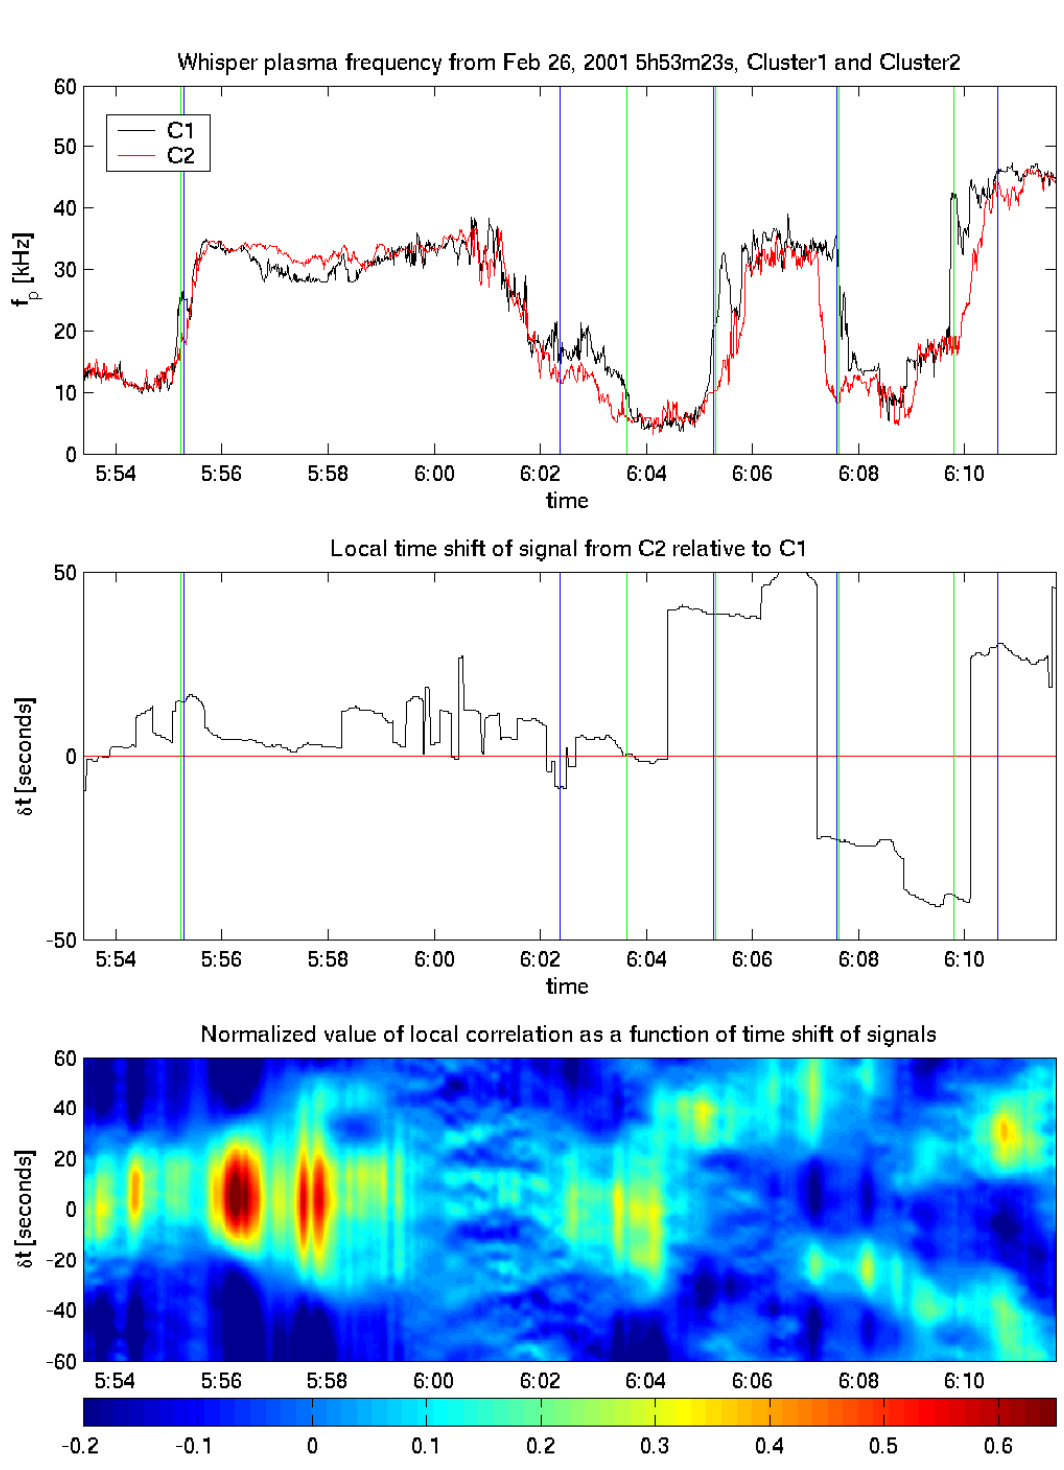
Fig. 1. Example of LWC timing, applied to the electron density measured by WHISPER during repetitive magnetopause crossings on 26 February 2001, from 5:54–6:11 UT. The upper panel shows the plasma frequency as measured by spacecraft C1 and C2. The middle panel provides the time lag for which the LWC is maximum. Positive values imply that C1 is preceding C2. The bottom panel displays the LWC versus lag and time; the color scale ranges from − 0.2 to 0.65. The approximate location of five magnetopause crossings are indicated by vertical green lines. In this example, 10th order Daubechies wavelets were used with a window derived from a 1-D Gaussian